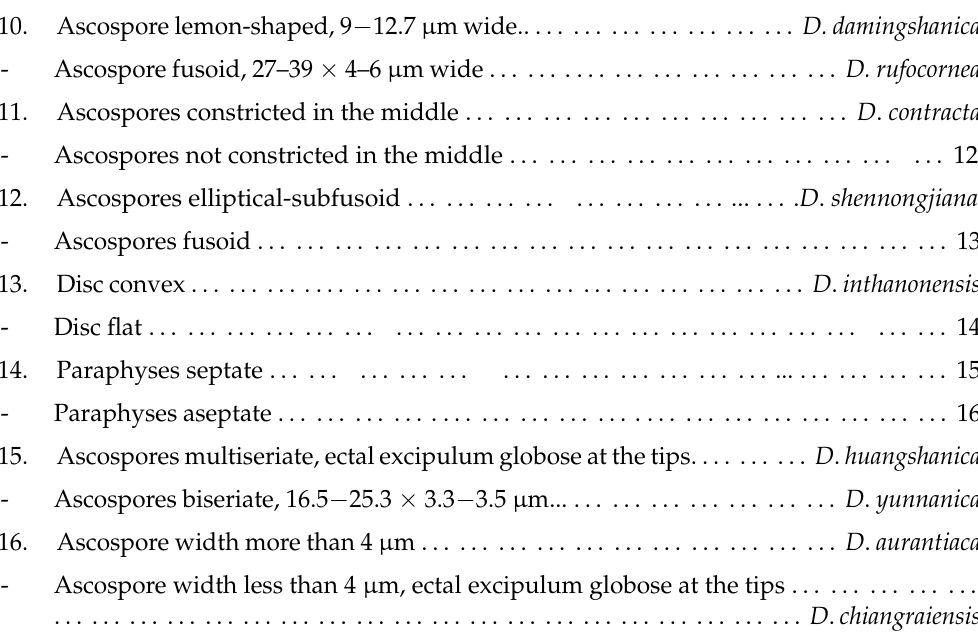
Ascospore width less than 4 µ m, ectal excipulum globose at the tips . . . . . . . . . . . . . .